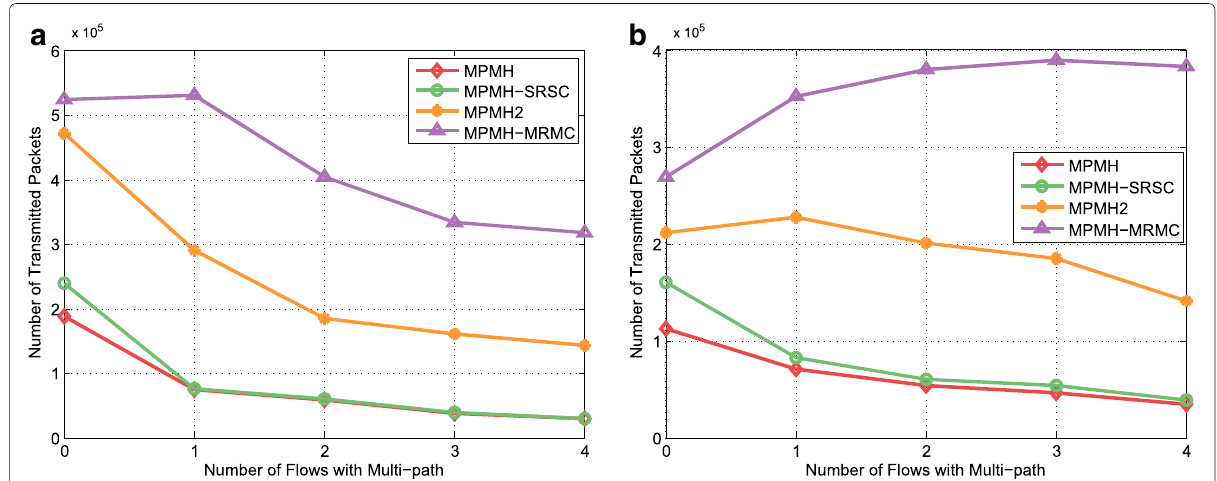
Fig. 6 Network throughput of the four MAC protocols under a different number of flows with multi-path. a Traffic load ratio is 25 with 10 flows. b Traffic load ratio is 10 with 4 flows